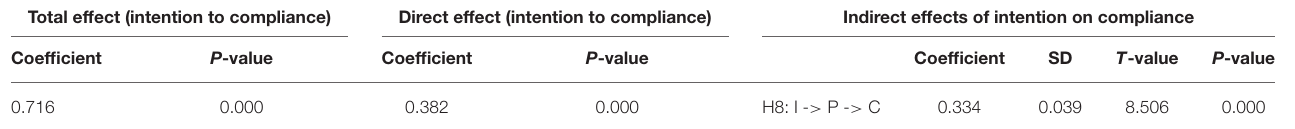
TABLE 12 | Mediation analysis.